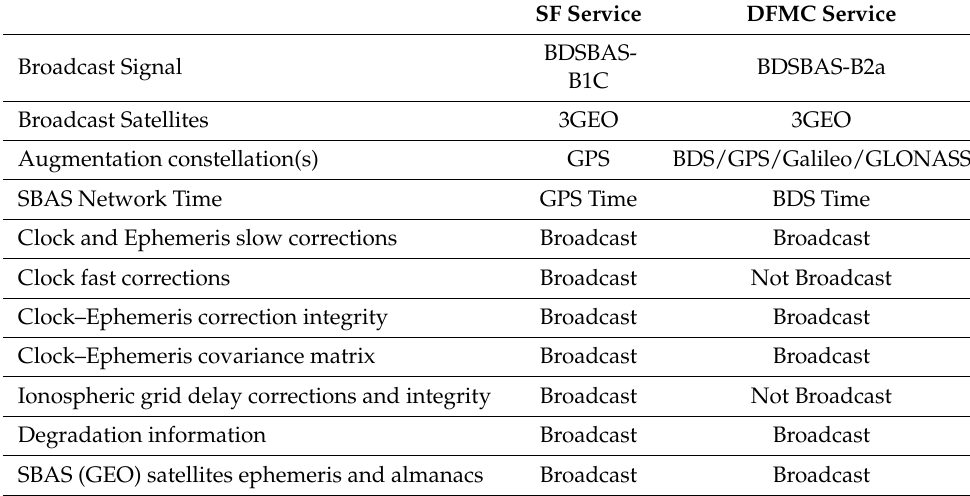
Table 1. Comparison of the BDSBAS SF service and the DFMC